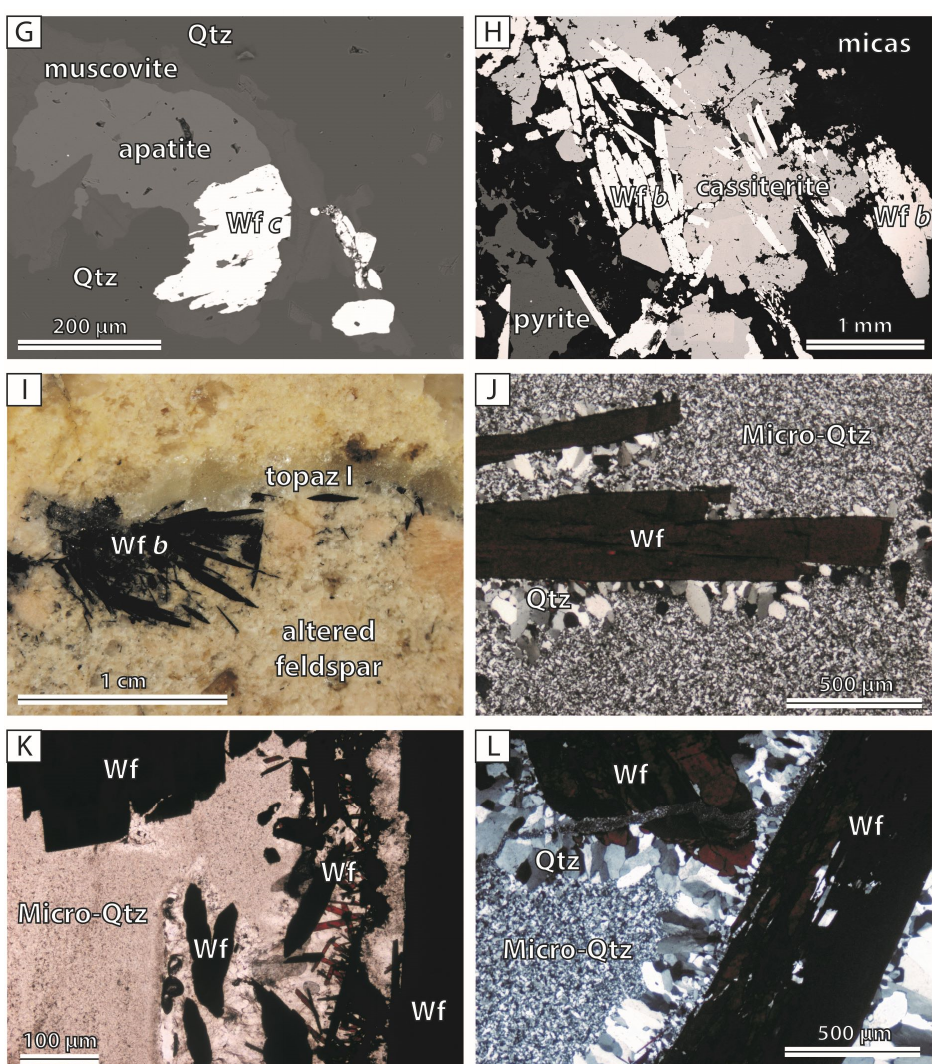
Figure 4. Photomicrographs illustrating habits of wolframite occurrences in the Echassières district: quartz vein of la Bosse stockwork ( A to G ); altered schist in the stockwork area ( H ); altered aplitic dike of la Bosse Porphyry ( I ); and Mazet veins ( J to L ). ( A ), ( B ): Plane‐polarized light (PPL) images of wolframite a crystals exhibiting corroded faces. Smaller wolframite grains may occur as inclusion in quartz recrystallized by grain–boundary migration (GBM). ( C ): Bismuth bearing minerals (russellite and Bi metal) associated to wolframite a . ( D ): XPL image of a small pocket in a quartz vein filled with wolframite b , topaz and scarce lepidolite (birefringent mineral). ( E ), ( F ): Same image viewed in PPL and XPL, respectively. Wolframite b plus topaz and fans of lepidolite in a quartz vein. Lepidolite and topaz are altered to greisen muscovite, itself partially altered by kaolinite. ( G ): Wolframite c accompanied by greisen minerals apatite and muscovite, within a fracture in a quartz vein. ( H ): Rods of wolframite b associated with anhedral cassiterite and pyrite, in altered schist (BSE). ( I ): Wolframite b and topaz in altered potassic feldspar crystals (binocular microscope view of a polished sample). ( J ) to ( L ): Rods of wolframite c in a microquartz groundmass (Mazet vein). Well crystallized quartz grows on some wolframite faces, perpendicularly to them. Images were taken in XPL ( J and L ) and PPL ( K